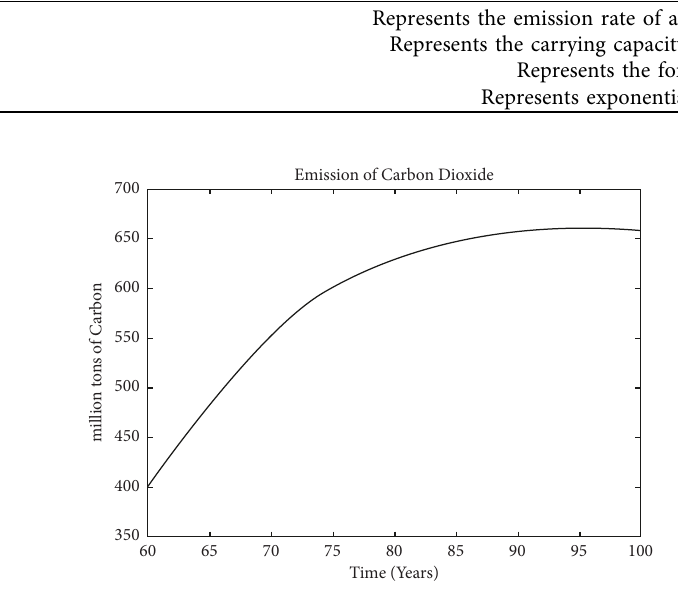
Figure 1: Graphical representation of million tons of CO